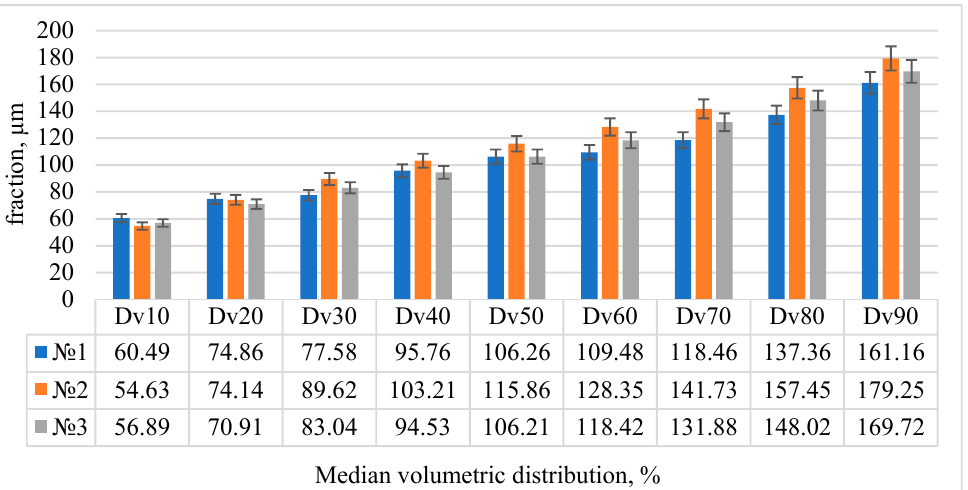
Figure 6. Standard percentiles of the particle size distribution in microns (Dv(n)). The morphology of the powder particles obtained by flame atomization was studied (Figure 7a–c). The morphology of the powder particles with added silver was the same as that of the powder particles without added silver. The powder obtained by flame atomization showed high sphericity and roundness with a minimum number of defects, according to the Krubien-Schloss diagram.